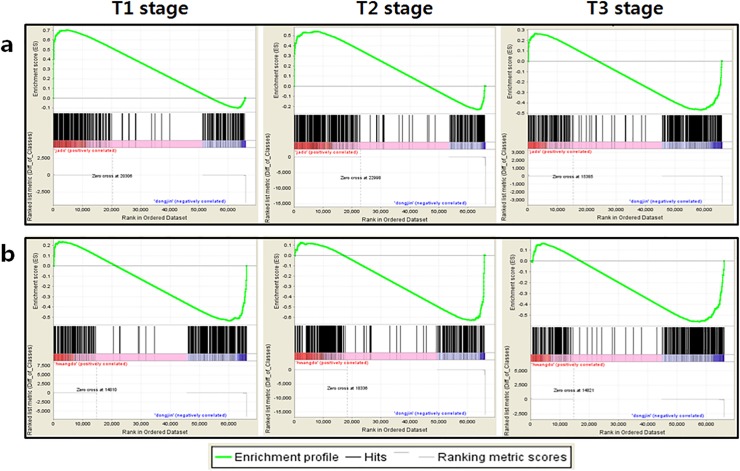
Gene-expression profiling for anthocyanin biosynthesis using gene-set enrichment analysis (GSEA) score curves.Examples of enrichment plots are shown for categories identified using the GSEA method at three different stages of leaf development (germination + 30 days, + 45 days, and + 60 days) between the (a) Jado and (b) Hwangdo cultivars. Black bars represent the positions of members of the category in the ranked list together with the running enrichment score (plotted in green).